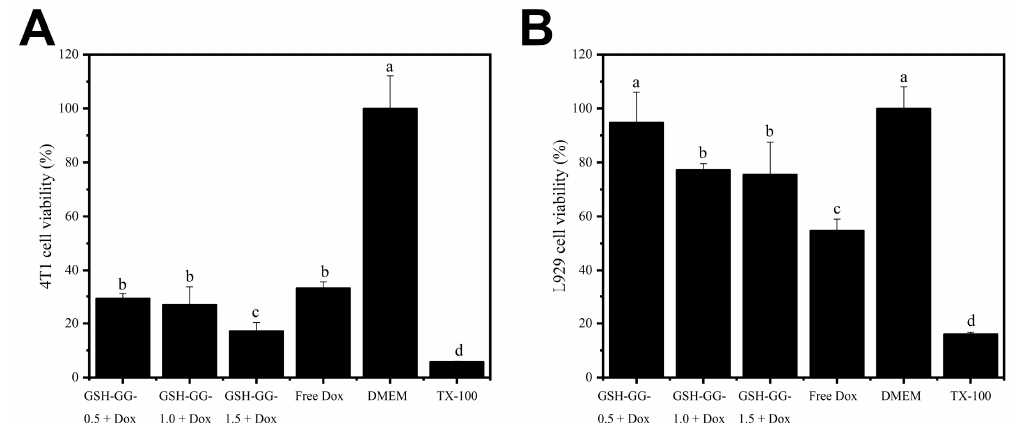
Figure 5. The cytotoxicity of DOX-loaded GSH-GG against 4T1 ( A ) and L929 ( B ) cells. a–d Means in